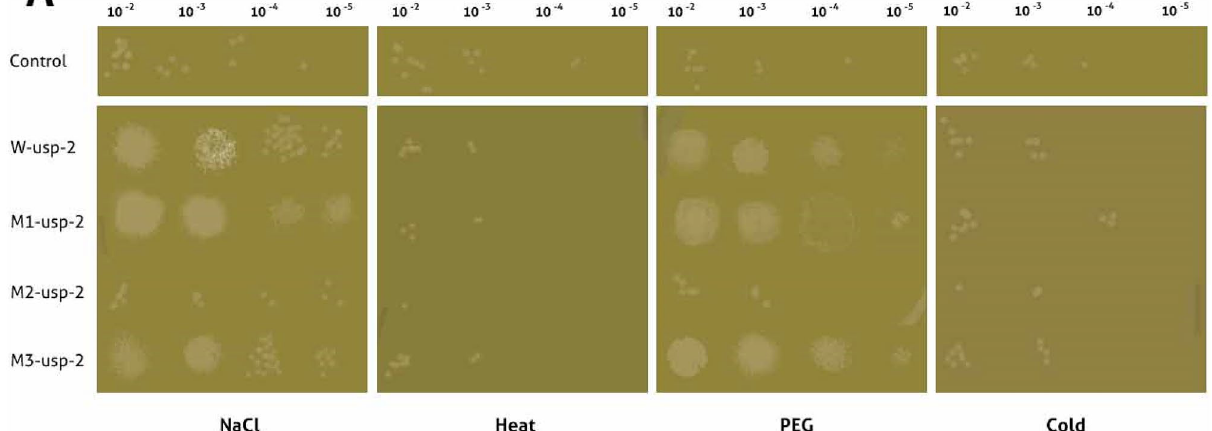
Figure 3. Spot assay of E. coli-BL21-uspABC. Transformed BL21-usp-ABC cells with wild type ( W-usp-2 ) and mutant ( M1-usp-2 , M2-usp-2, M3-usp-2 ) genes were spotted on LB plates supplemented with salt (800 mM NaCl), PEG (8%). For heat stress, after 2 h of induction (IPTG) 1 ml culture was inoculated in 10 ml media (LB) and incubated at elevated temperatures (46 °C). Samples were removed after 8 h and spotted on respective plates. For cold stress, spotted plates were removed from 4 °C after 10d and photos were taken after incubation at 37 Supplementary data). Positive transforment number 2, 6 from r Mp1 , 2 from r Mp2 and 5 from rMp3 gener- ated two fragments of 510 bp and 3.8 kb (Fig. S5A-C, Supplementary data) and were further confirmed with Sanger sequencing (Fig. S6A-C, Supplementary data). The confirmed clones were named Tm1-GP-2 , Tm2-GP-2 & Tm3-GP-2 respectively. TA constructs of mutants ( Tm1-GP-2, Tm2-GP-2 & Tm3-GP-2 ) were used for cloning pET-30b expression vector and transformation into wild type and mutated E. coli expression strains (Table S7, Supplementary data) for functional validation. Five colonies were picked randomly from each transforments (r pE1, rpE2 , r pE3 & r pW ) and screened via colony PCR (Fig. S7A,B, Supplementary data). Clone number 2 & 3 of r pE1 (Fig. S8A, Supplementary data), 7, 9 & 11 of r pE2 (Fig. S8B, Supplementary data), 2, 3, 4 & 6 of r pE3 (Fig. S8B, Supplementary data) and 7, 8, 9 & 10 of r pW were positive. Positive transforment number 3 from r pE1 , 9 from r pE2, 4 & 6 from r pE3 and 8 & 9 from r pEw generated two fragments of 510 bp and 5.2 kb (Fig. S7A,B, Supplementary data) were confirmed positive and named M1-CeS1 , M2-CeS2, M3-CeS2 and W-CeS respectively. Functinal validation under various abiotic stress conditions.